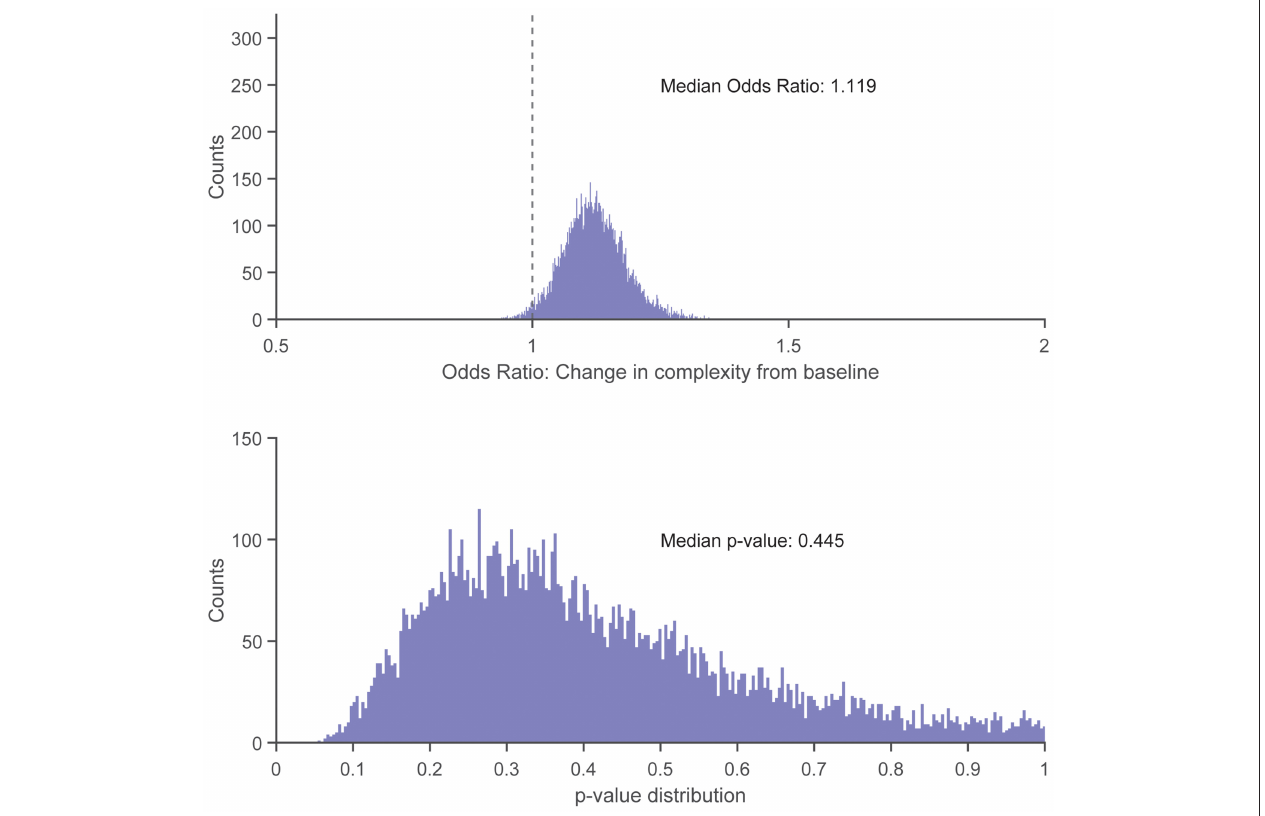
FIGURE 6 | Histogram showing distribution of odds ratios (Top) and p -values (Bottom) for the increase in injury odds per 0.01-unit increase in change from baseline complexity (calculated as pre-injury complexity minus baseline complexity), across 10,000 replicates of the frequency-matching procedure. “Pre-injury” complexity was the last observed complexity value prior to reported injury in the injured group and the date-matched run of the control group resulting from the frequency-matching procedure. The vertical dashed line in the top panel indicates the null hypothesis of no association (odds ratio = 1.0); 98.27% of the model replicates resulted in an odds ratio >